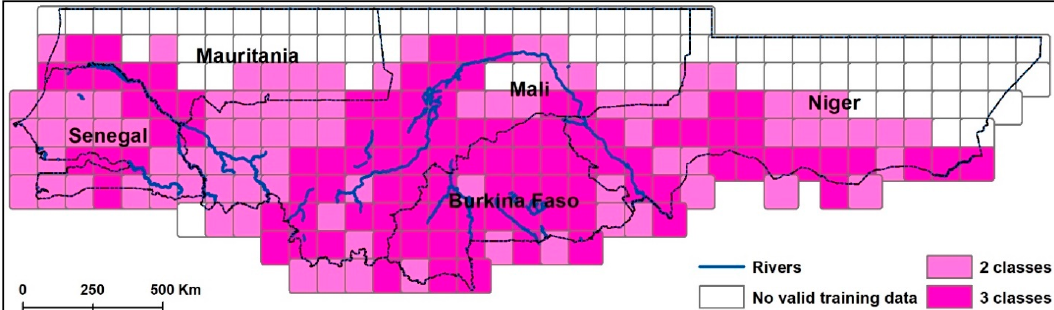
Figure 5. Cells with valid training data (i.e., containing two or more classes (crop and non-crop) after reclassification of the training grid points). A total of 189 cells among the 267 include some cropland in the training data allowing us to run the RF algorithm. 3-classes occur only in those regions with irrigated cropland, mostly associated with the major rivers in the